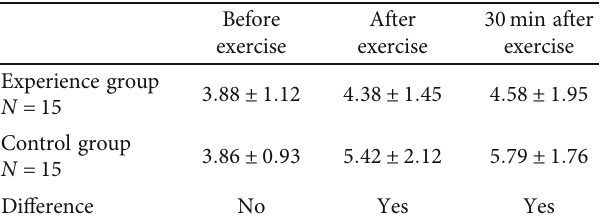
Figure 10: ALT values of the two groups at di ff erent times. Table 3: Creatine kinase activity